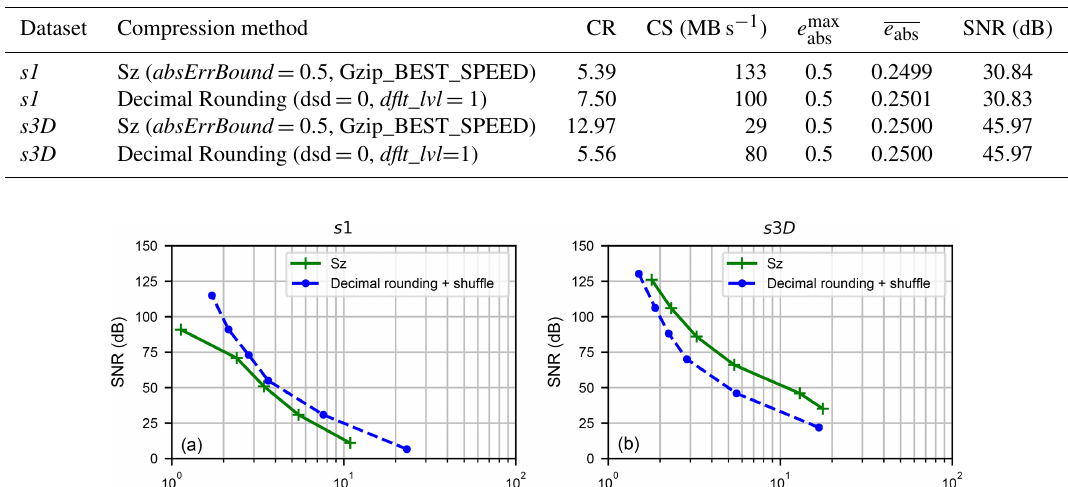
Table 5. Compression results of the absolute error-bounded compression algorithms Sz and Decimal Rounding on datasets s1 and s3D .